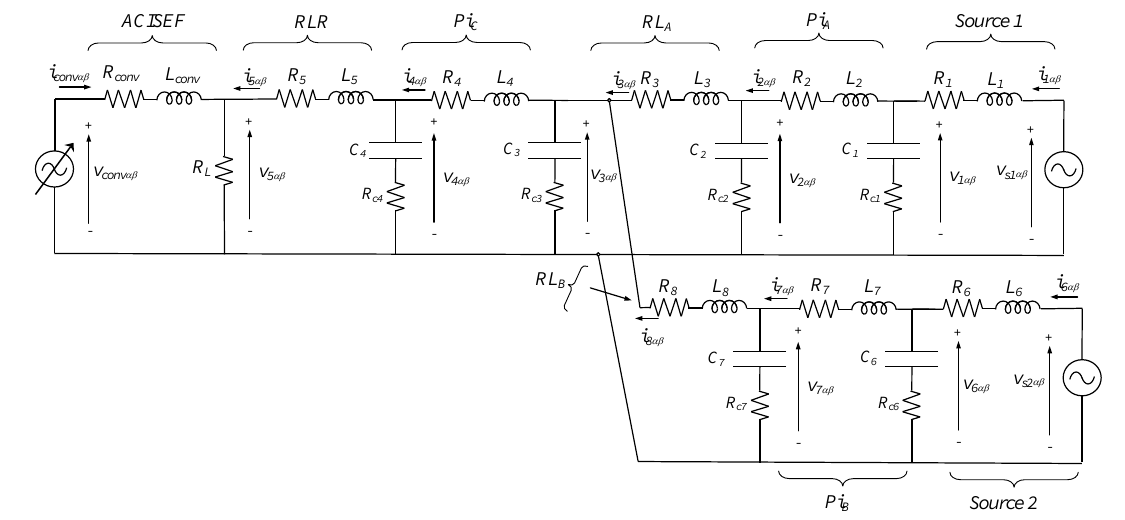
Figure 20. Equivalent AC grid with more than one branch.